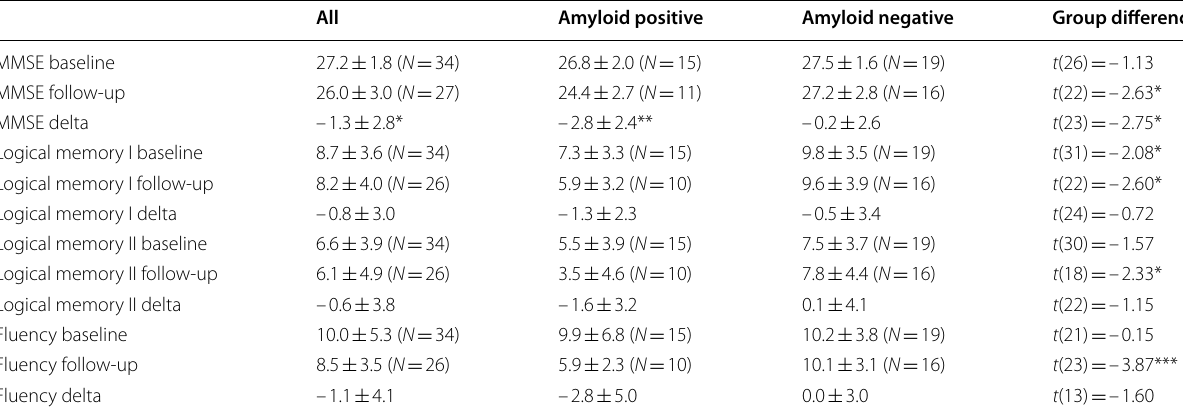
For different tests delta refers to difference between baseline and follow-up in amyloid-positive and amyloid-negative groups separately and stars denote significance levels in paired t test between baseline and follow-up measures: * p < 0.05, ** p < 0.01, *** p < 0.001